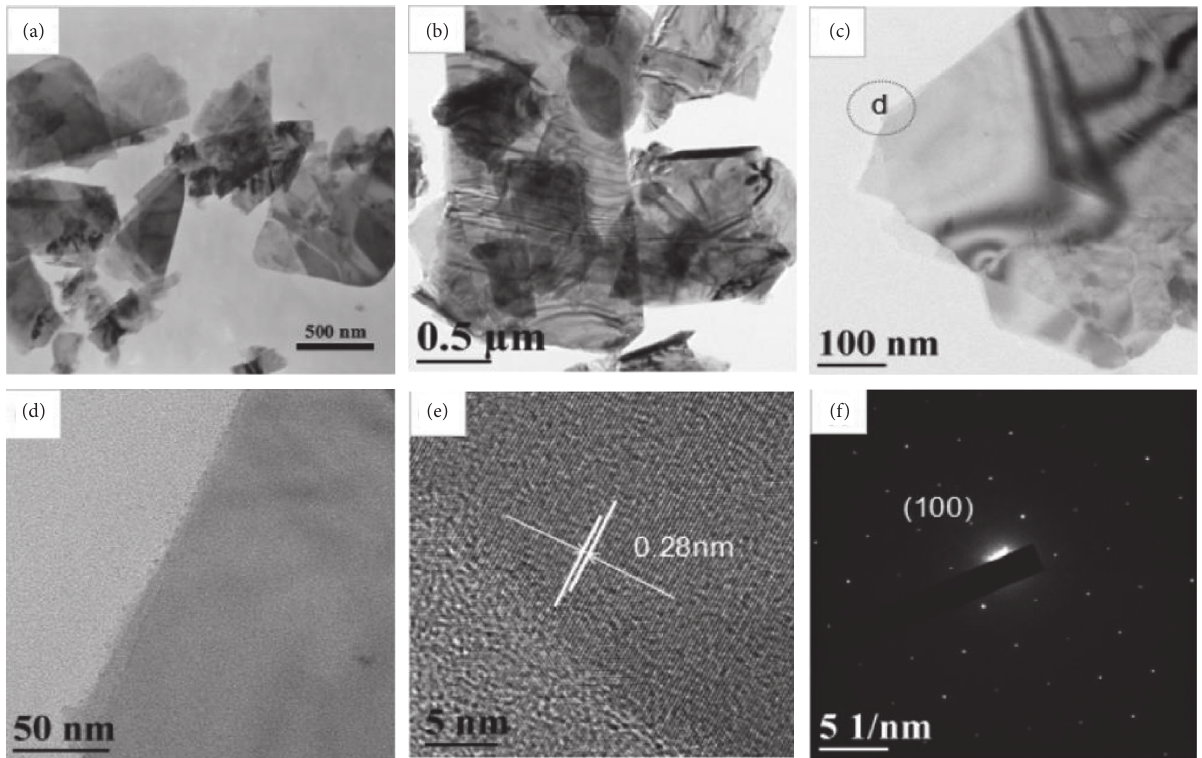
Figure 17: (a) and (b) TEM images of MoS 2 nanosheets and (c) TEM image of nanosheets stacked together. (d) and (e) HRTEM image of the circle area marked in (c) and the corresponding SAED pattern (f) to (d)